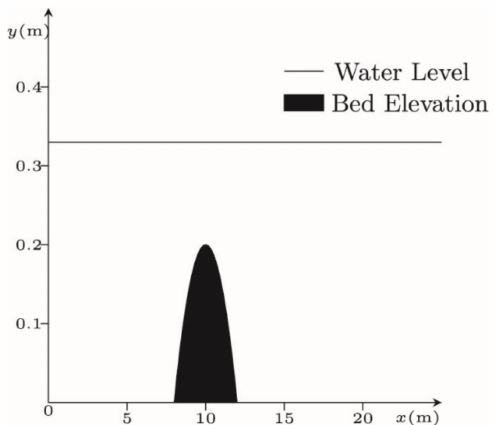
Figure 7. Bed elevation and initial water free surface distributions along a channel for the case of transcritical flow over a bed hump.